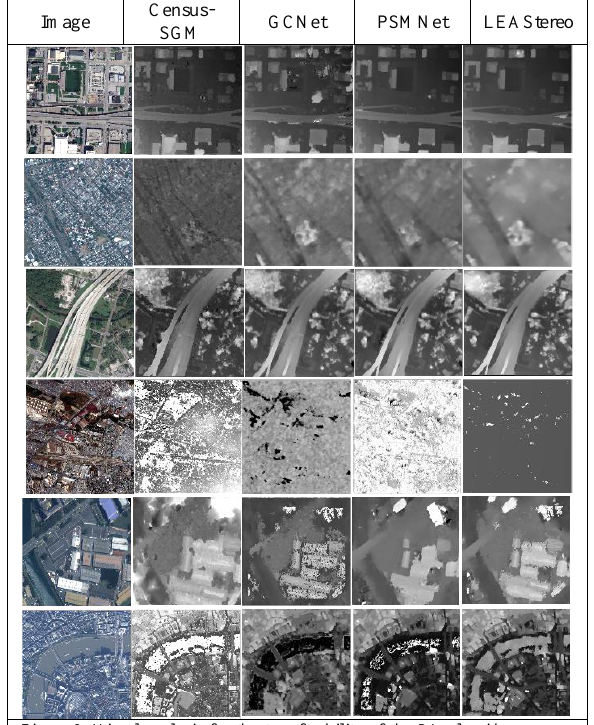
Figure 3. Visual analysis for the transferability of the DL algorithms across different study sites. Note: the rows from 1-6 show Omaha I, Argentina III, Jacksonville II, Haiti II, Rochor I Singapore, and London study sites,